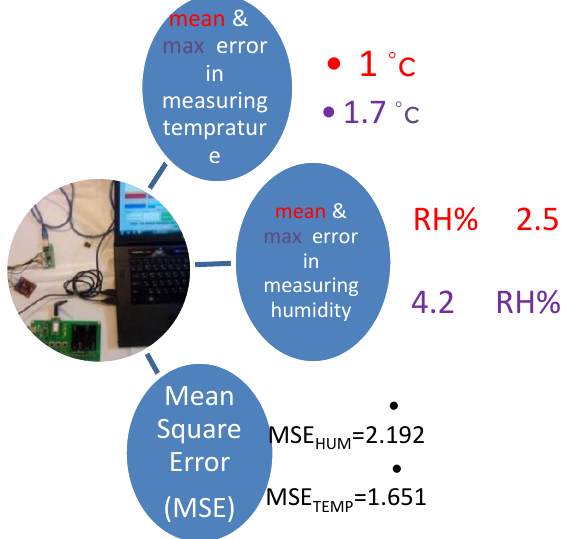
Figure 20. Maximum error, mean error, and MSE values for temperature and humidity parameters monitored by proposed system.